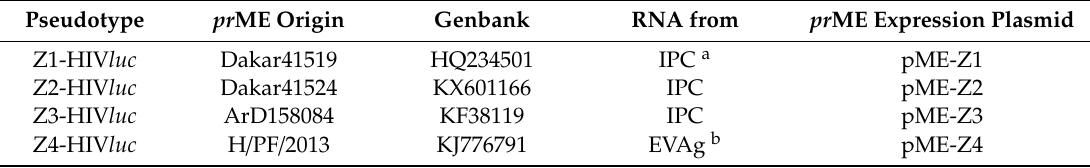
Table 1. Zikavirus pr ME pseudotyped HIV-1 used in the